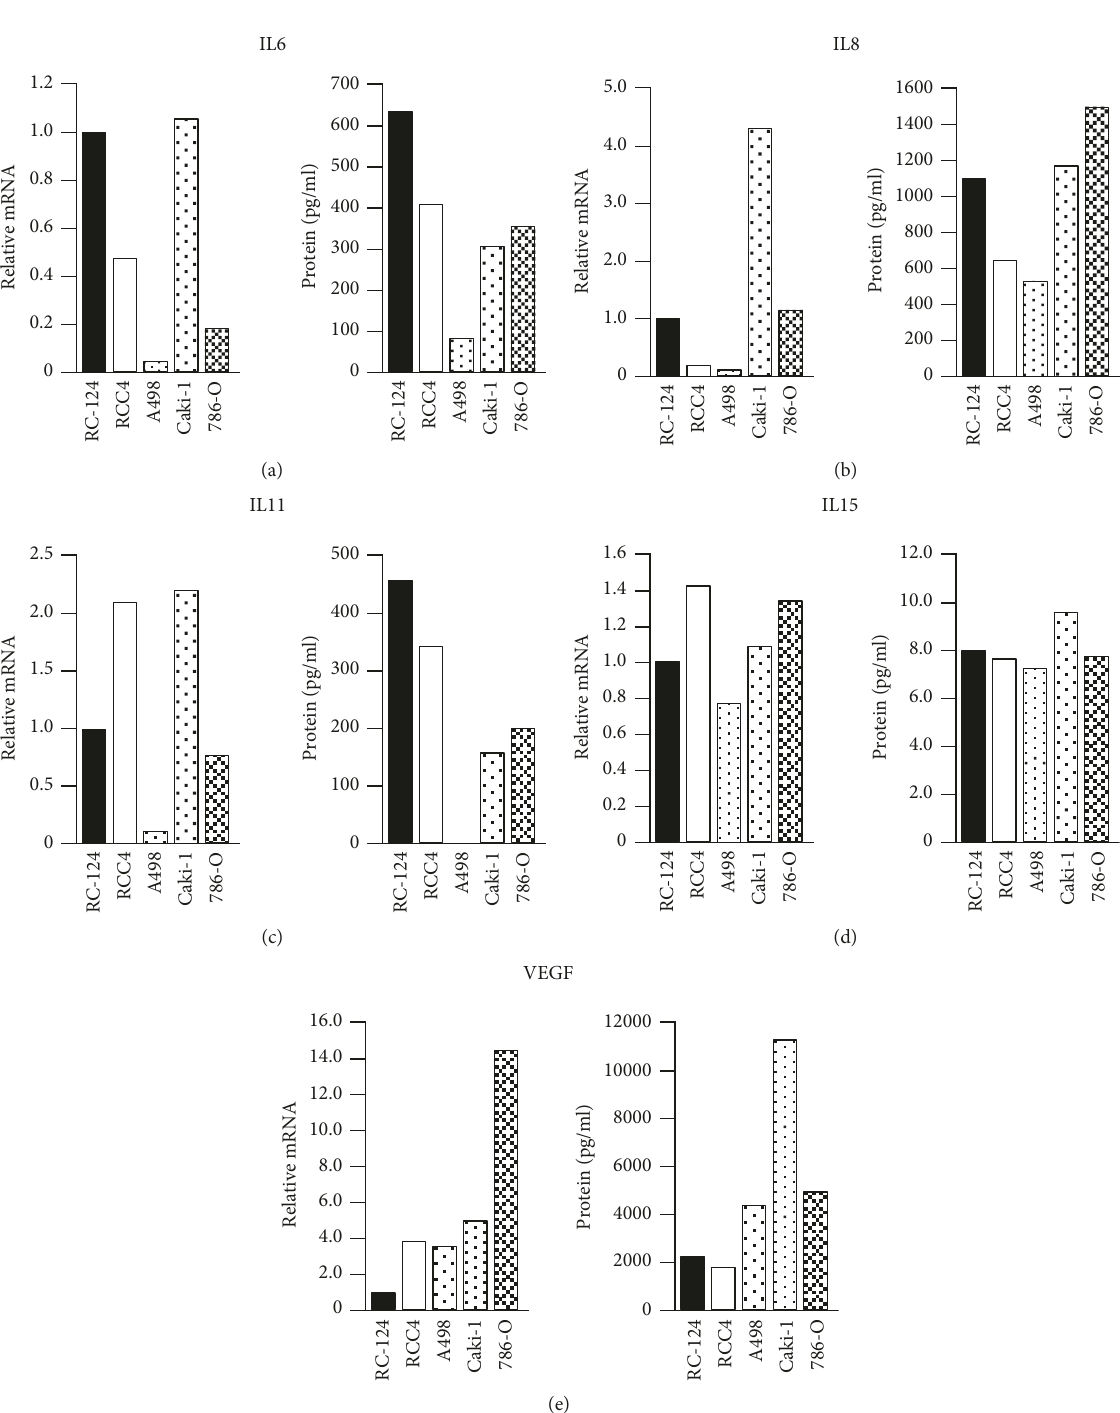
Figure 2: Comparison of mRNA levels and protein levels of selected cytokines. Steady-state levels of intracellular mRNA levels and extracellular protein levels of IL6 (a), IL8 (b), IL11 (c), IL15 (d), and VEGF (e) were assessed by quantitative DNA array (Human Cytokines & Chemokines RT 2 Pro fi ler PCR Array; Qiagen) and enzyme-linked immunosorbent assay (ELISA) analysis, respectively. mRNA amounts are expressed as relative mRNA levels normalized to nonmalignant RC-124 cells (RC-124 mRNA=1.0). Protein levels are expressed as pg protein/ml cell culture